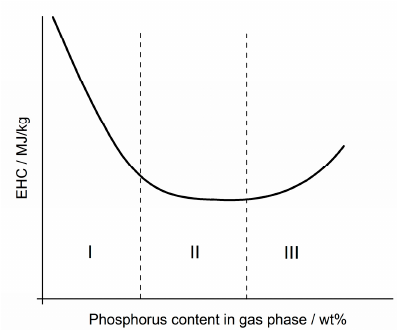
Figure 8. Proposed model for the dependency of effective heat of combustion on the phosphorus content released into the gas phase based on previous work by Brehme et al. [31]. The curve progression follows a linear decrease of EHC (I) and leads to a leveling off of EHC reduction (II). Further phosphorus increase is proposed to have a negative impact on efficiency, thus the increase in EHC (III).